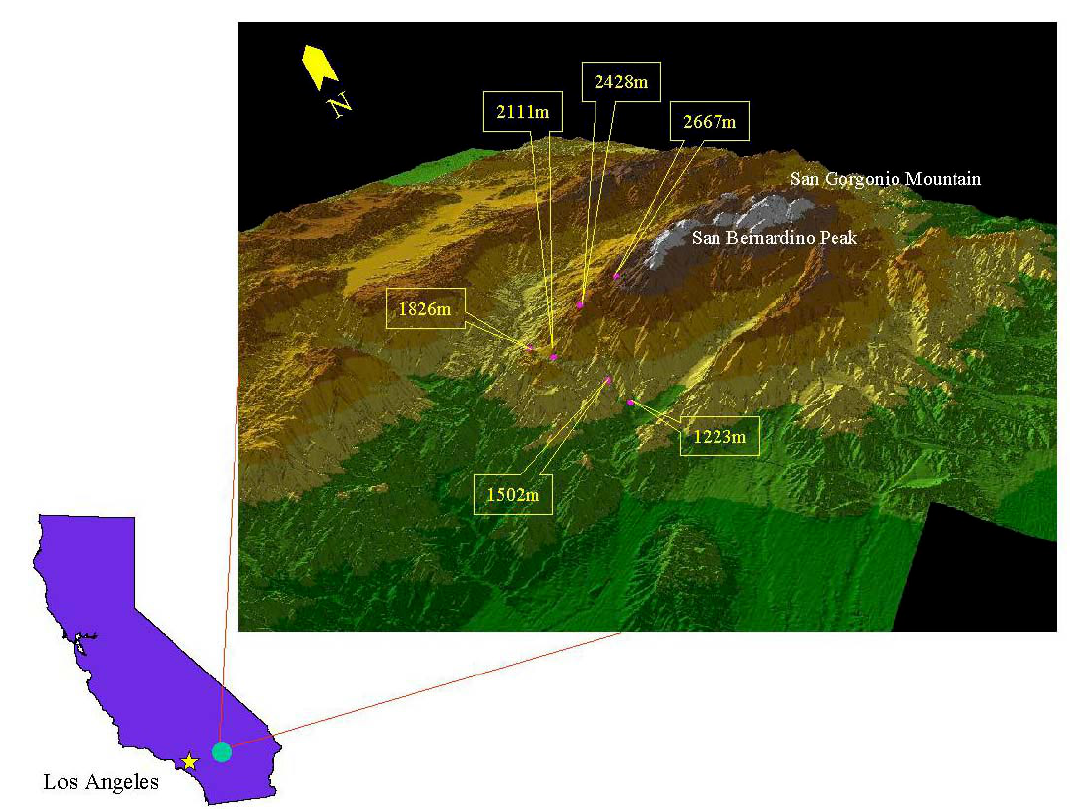
FIGURE 1. Location of the monitoring sites along an elevation gradient in the San Bernardino